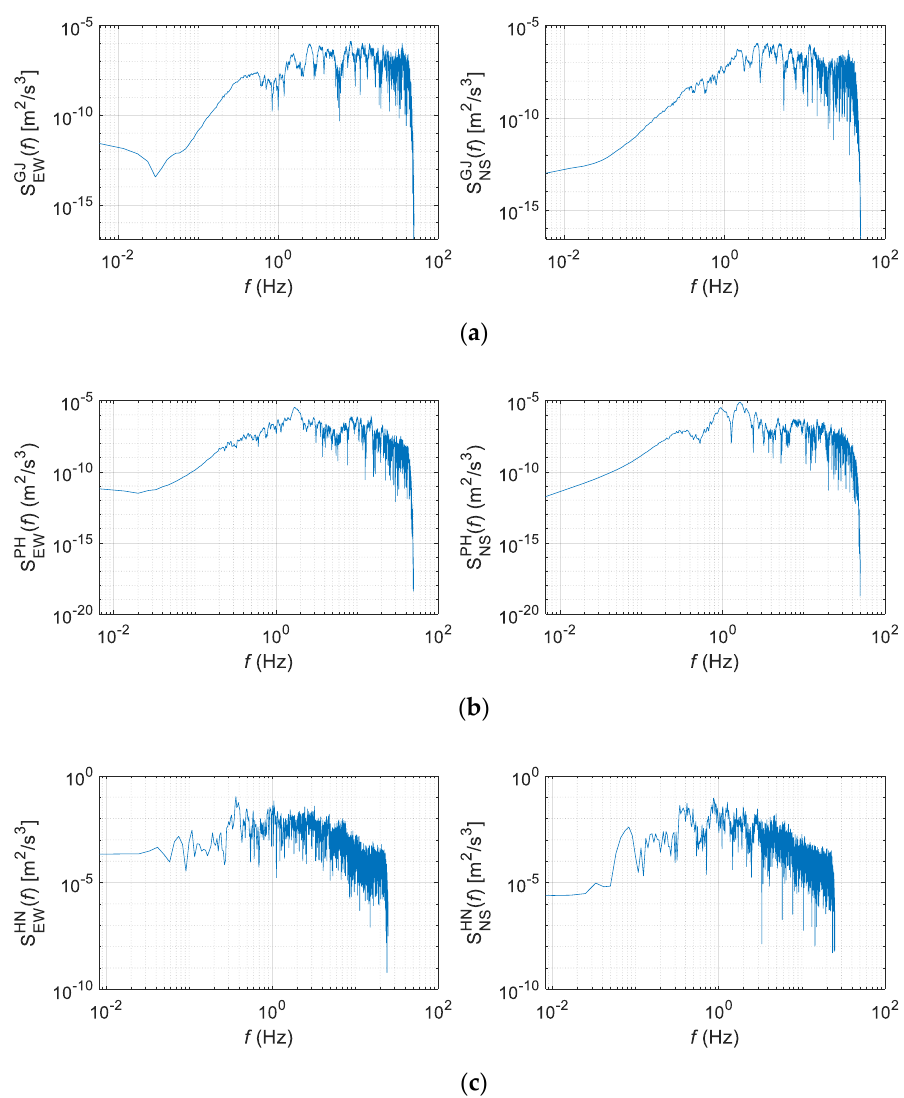
Figure 4. Power spectral densities (PSDs) of ( a ) Gyeongju (2016), ( b ) Pohang (2017), and ( c ) Hachinohe (1994).